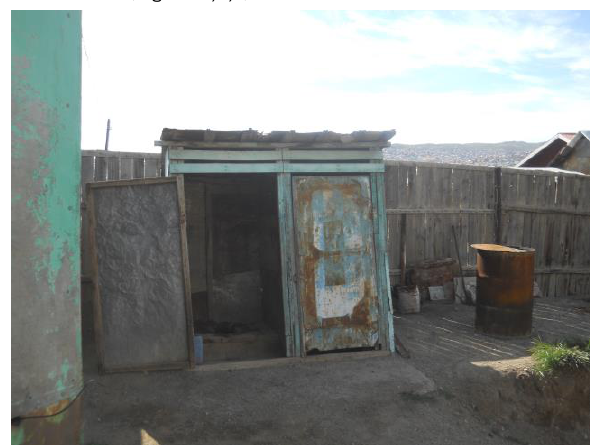
Figure 6. Pit latrines in ger area of Ulaanbaatar, Mongolia